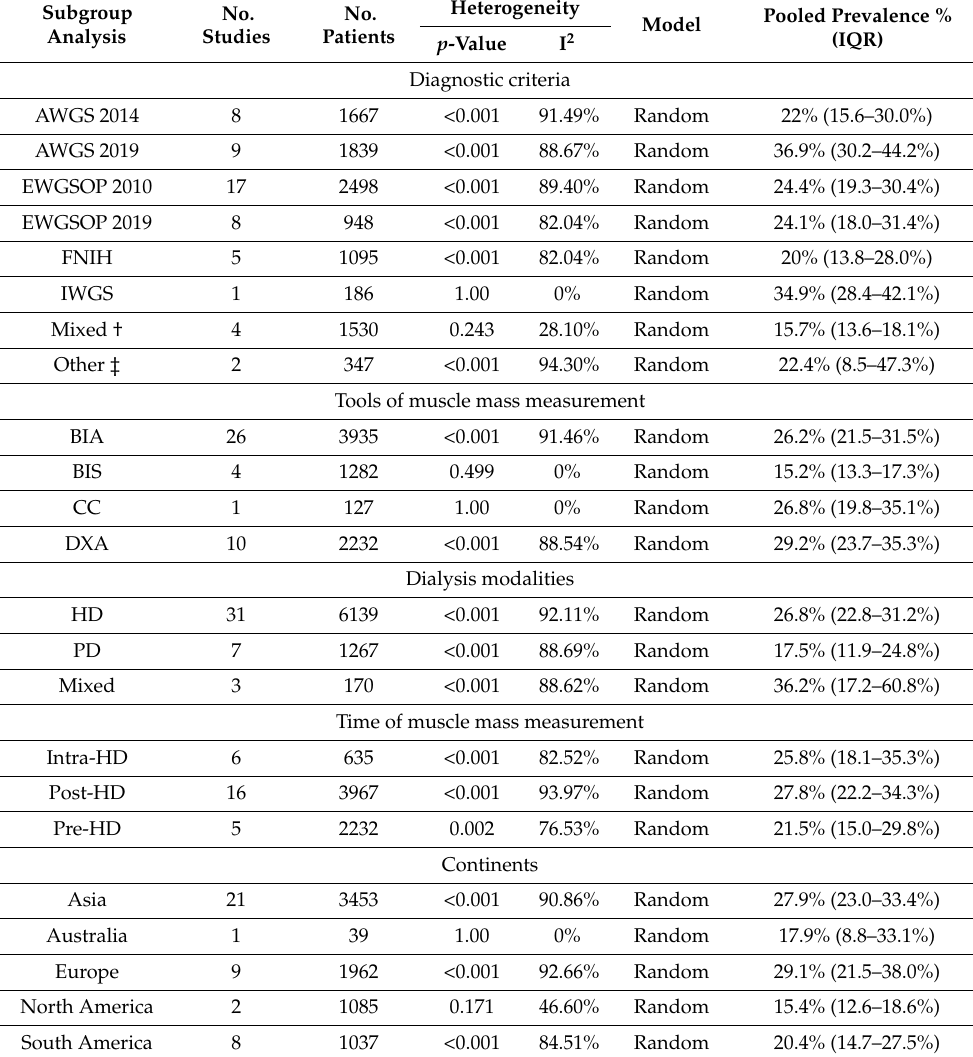
Table 2. Subgroup analyses examining the pooled prevalence of sarcopenia in different variables among dialysis